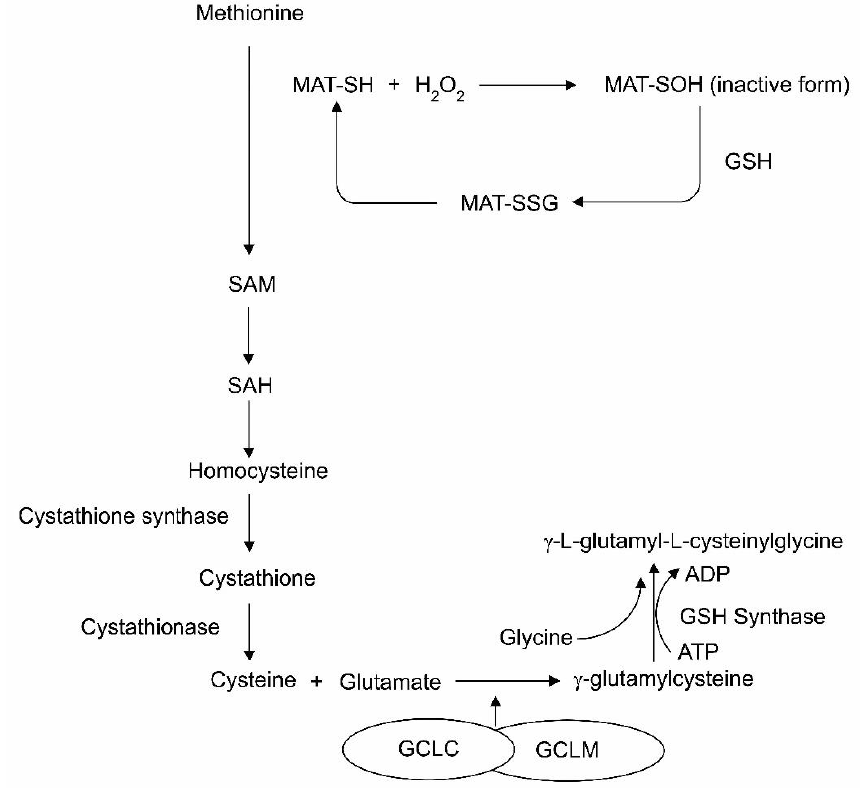
Figure 1. Glutathione biosynthesis and the role of glutathione on the reactivation of MAT-SOH. Hydrogen peroxide (H 2 O 2 ) generated in the total parenteral nutrition (TPN) reacts with the –SH group of methionine adenosyltransferase (MAT), converting it to –SOH, which is the oxidized form of the thiol group, resulting in a vicious cycle. The reduced form of glutathione (GSH) reforms the MAT-SH from MAT-SOH by generating MAT–mixed disulfide (MAT-SSG). SAM, S-adenosylmethionine; SAH, S-adenosylhomocysteine; GCLC, catalytic subunit of glutamate–cysteine ligase; GCLM, modifier subunit of glutamate cysteine ligase.